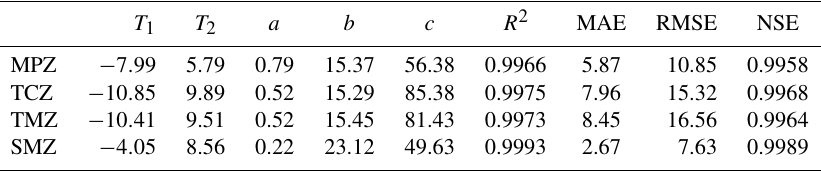
Table 2. The parameters required for the calculation of the monthly accumulated positive air temperature (PDD) and the statistical analysis between the calculated and measured monthly PDD in four different climatic zones of China. T 1 T 2 a b c R 2 MAE RMSE MPZ